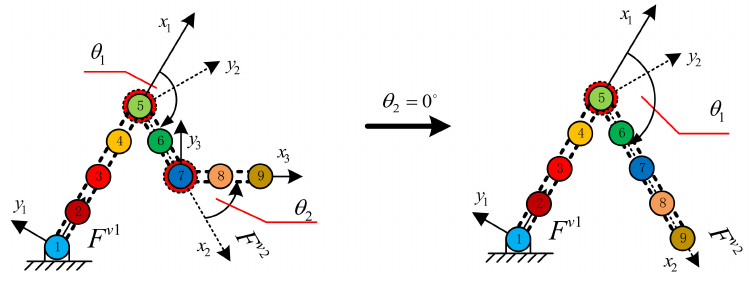
Figure 22. Schematic of the designed virtual